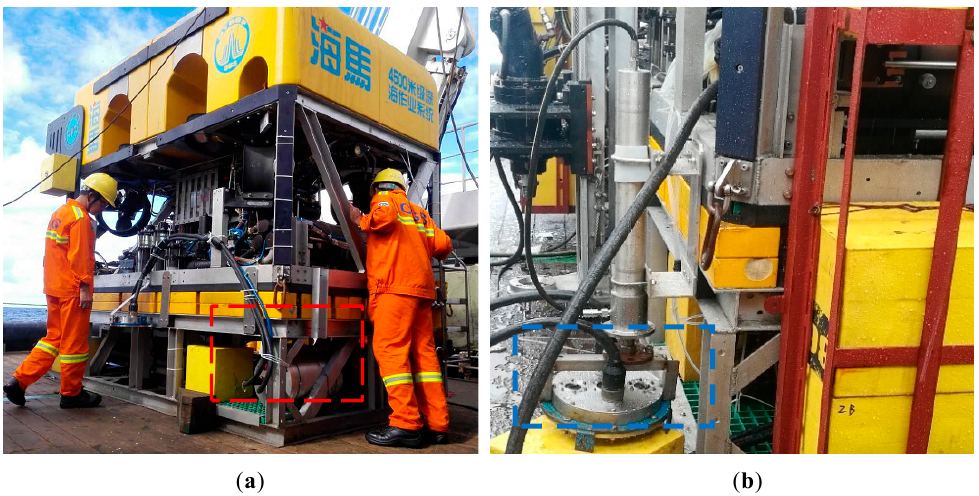
Figure 7. The experimental configuration of PPPAAP17: ( a ) The electronic unit; ( b ) The transmitter transducer array and receiving transducer array mounted on the hydraulic system of the HAIMA